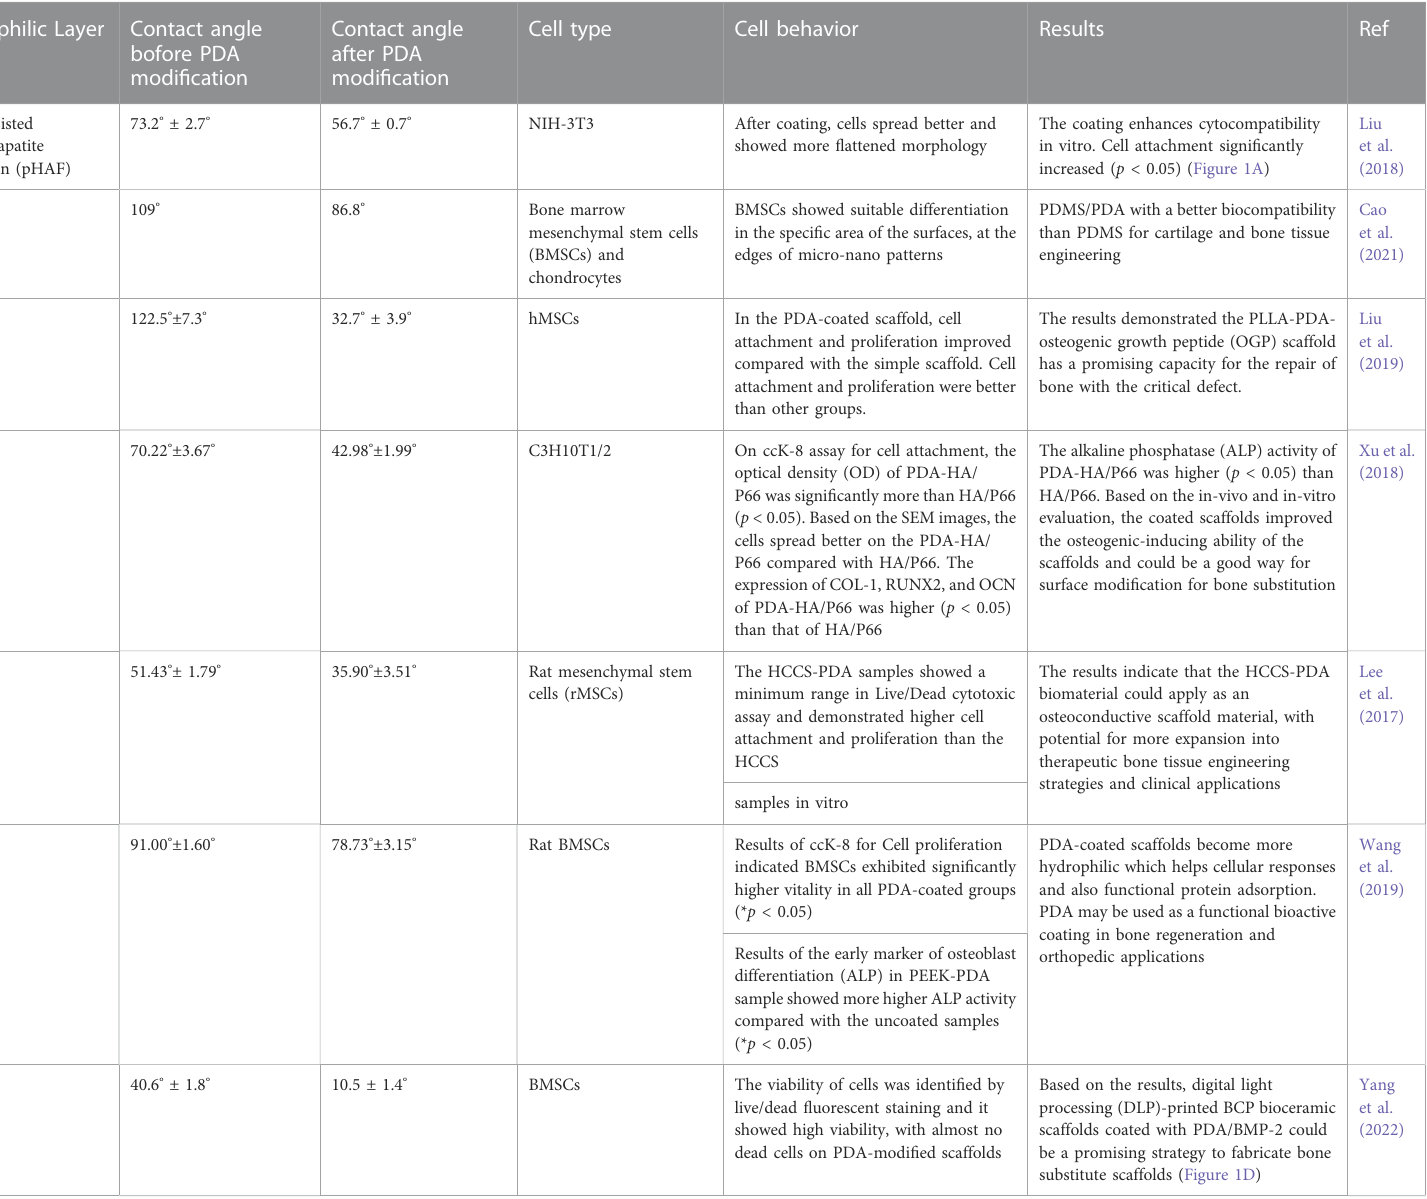
TABLE 1 Hydrophilic layer on scaffolds with